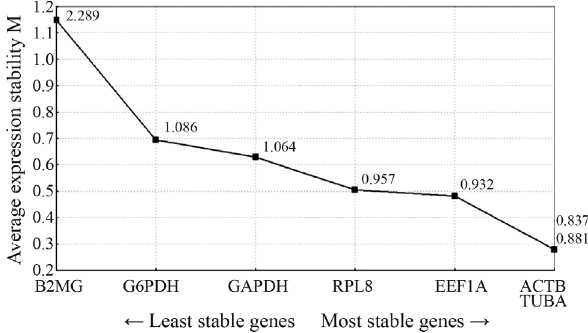
Figure 1 - Average values ( M ) of expression stability of reference genes analyzed by the GeNorm program. This graph displays the output of GeNorm plotting the M value against the reference genes within every sampling from each